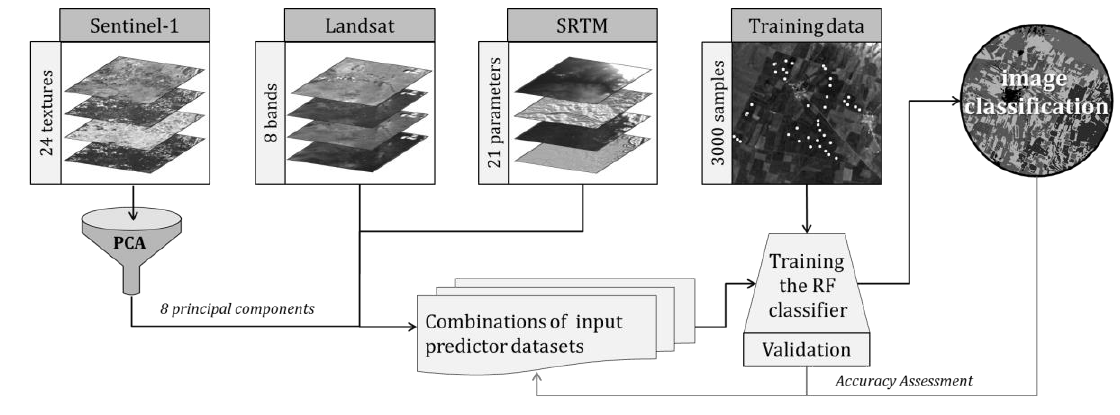
Figure 4. Workflow of the